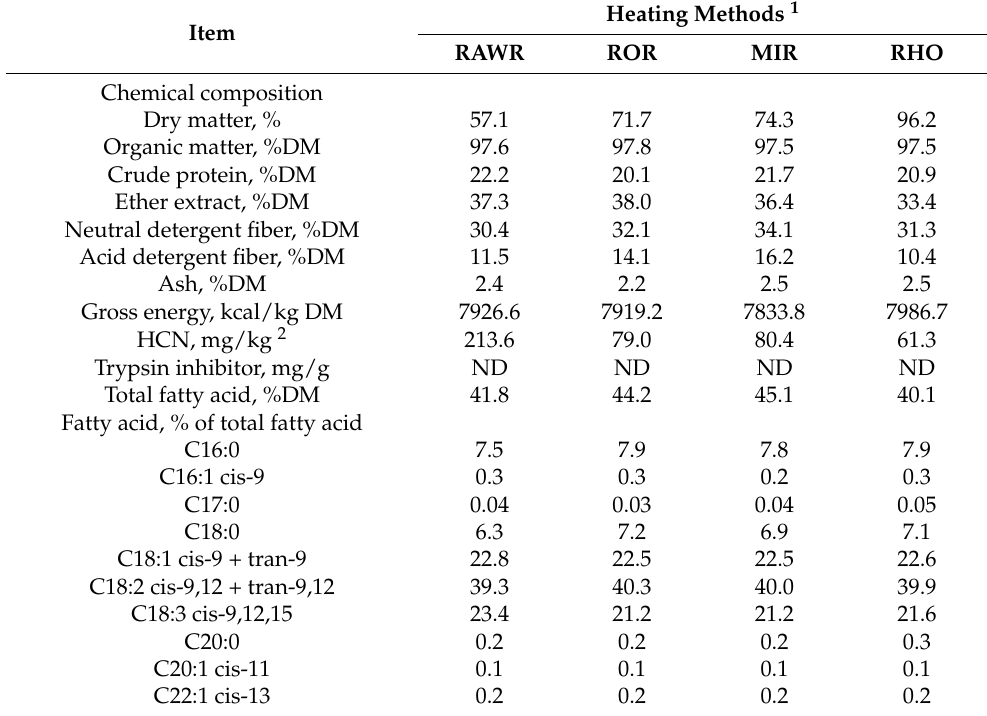
Table 2. Chemical compositions of different heating of rubber seed